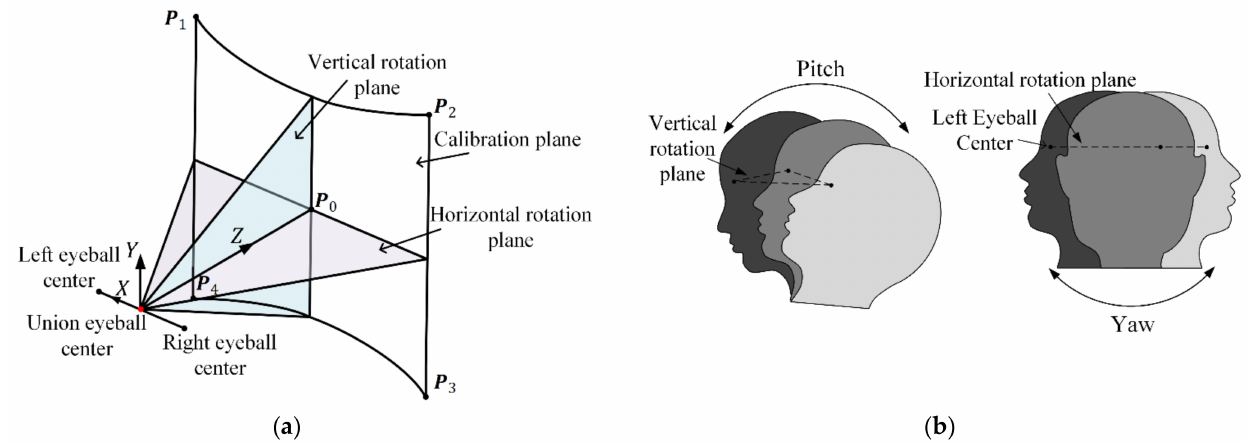
Figure 5. Illustration of sampling strategy for calibration points. ( a ) The sampling range on calibration plane has four vertexes P 1 , P 2 , P 3 , P 4 as limits. The polar coordinate ( α , β ) of P 0 , P 1 , P 2 , P 3 , P 4 are ( 0 ◦ ,0 ◦ ) , ( − 30 ◦ ,25 ◦ ) , ( 30 ◦ ,25 ◦ ) , ( 30 ◦ , − 30 ◦ ) , ( − 30 ◦ , − 30 ◦ ) , respectively. ( b ) Calibration of the eyeball coordinate system. The left eye is taken as an example. The rotation pattern yaw and pitch are used to create horizontal rotation plane ( X − Z plane) and vertical rotation plane ( Y − Z